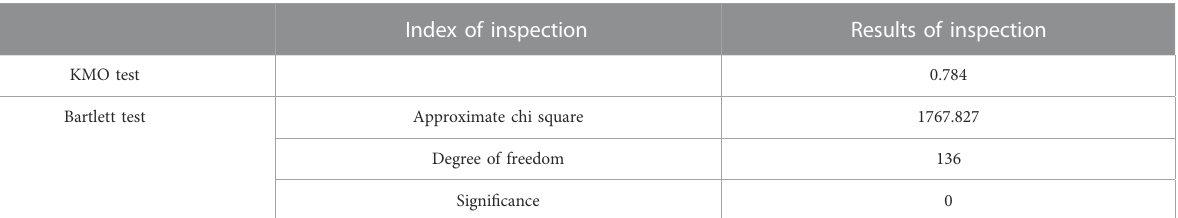
TABLE 3 KMO and spherical Bartlett tests of 17